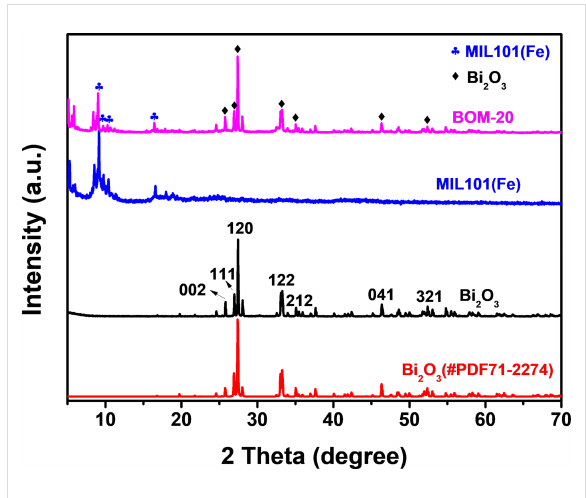
Figure 1: XRD patterns of MIL101, Bi 2 O 3 , and BOM-20.